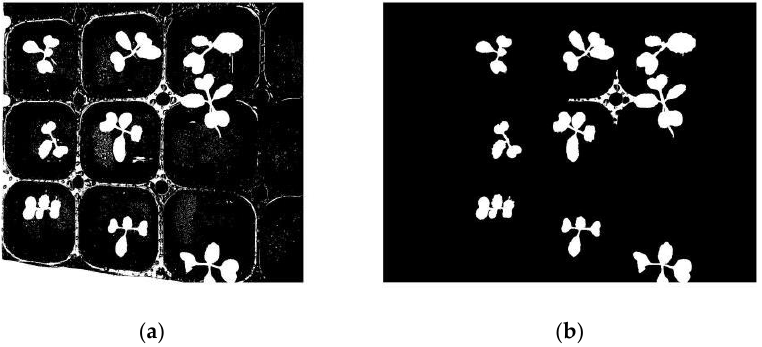
Figure 16. Binary and filtered images: ( a ) Binary image. ( b ) Filtered image.